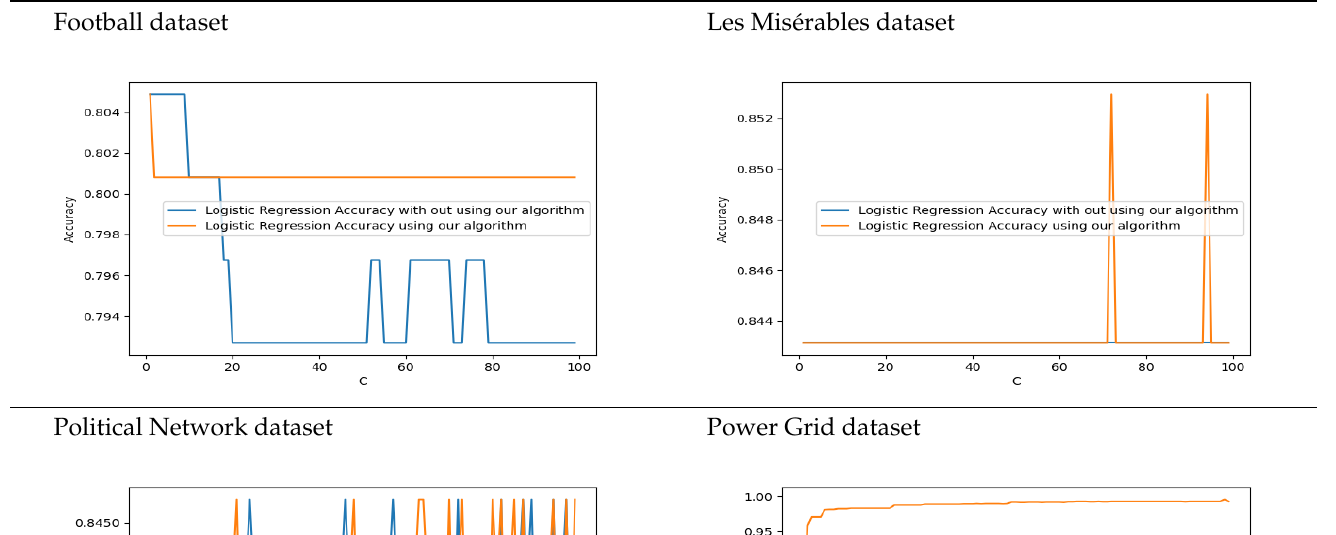
Table 7. The x axis represents the inverse of regularization strength. The y axis is the accuracy of the logistic regression